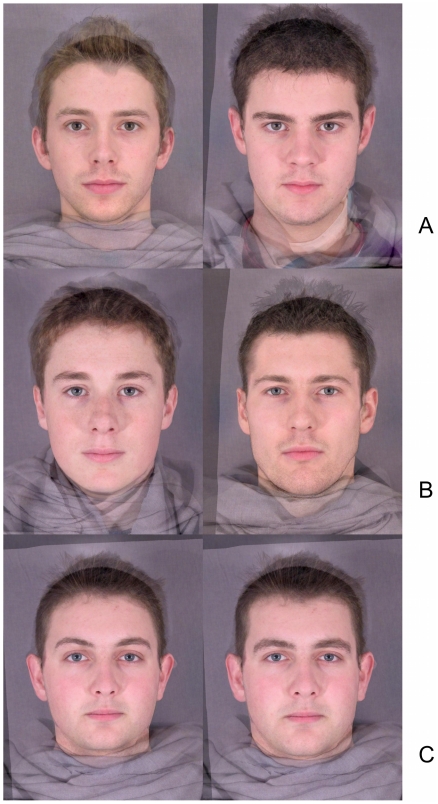
Masculinity, measured, rated and morphed: examples of dimensions.To preserve anonymity of participants, these faces are composites rather than real individuals. a) Morphological masculinity. Examples of faces scoring low (left) and high (right) on this measure. b) Rated masculinity. Examples of faces rated as low (left) and high (right) masculinity. c) Digitally morphed masculinity. Example of a face morphed in the feminine (left) and masculine (right) direction.